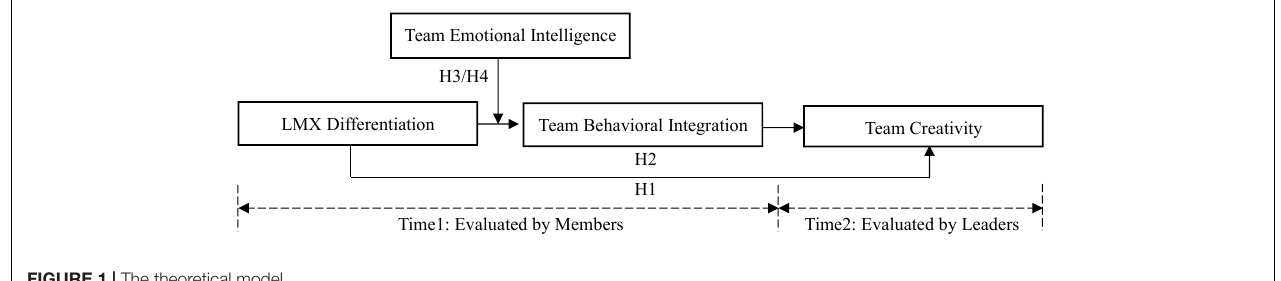
FIGURE 1 | The theoretical model.